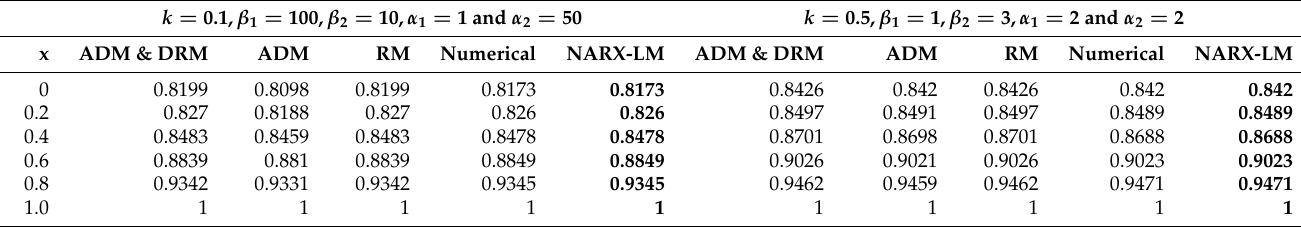
Table 2. Comparison of the solutions obtained by the NARX-LM algorithm with the numerical results, NM, ADM, and DRM for the steady state concentration of PGE.